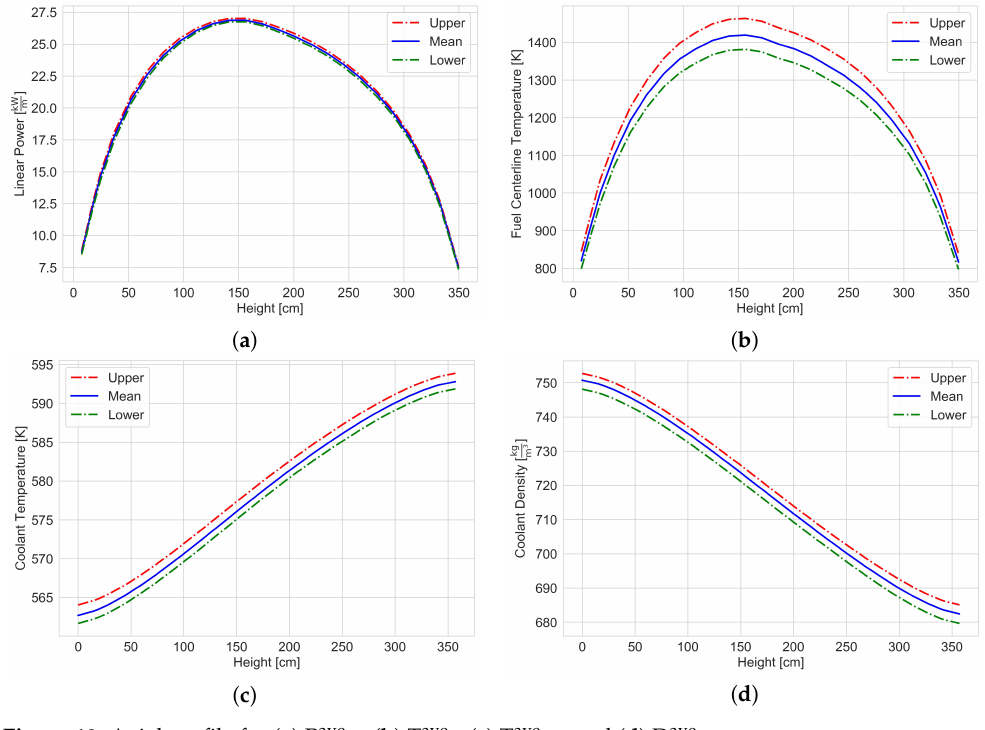
, ( b ) T ave , ( c ) T ave and ( d ) D ave lin,ax fc,ax cool,ax